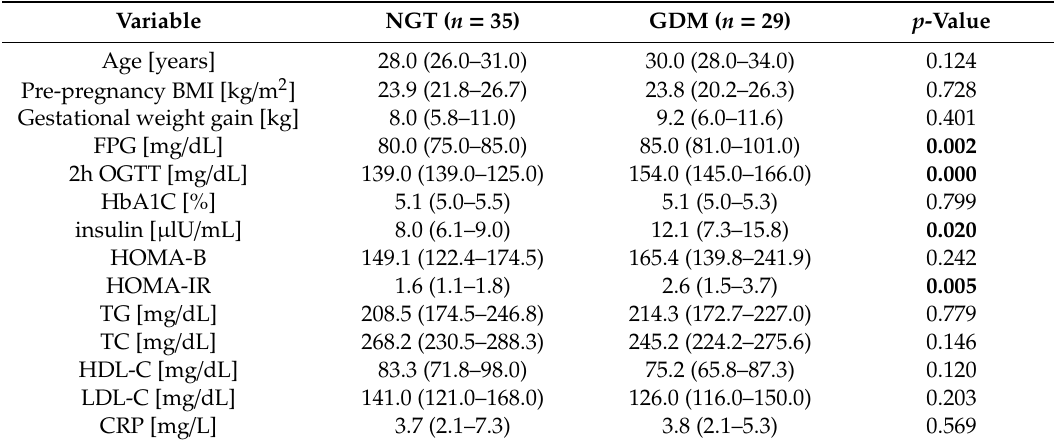
Table 1. Anthropometric and biochemical characteristics of pregnant patients involved in the study assigned to two study groups: normoglycemic (NGT) and gestational diabetes mellitus (GDM). Data are presented as the median and interquartile range (25–75 percentiles).